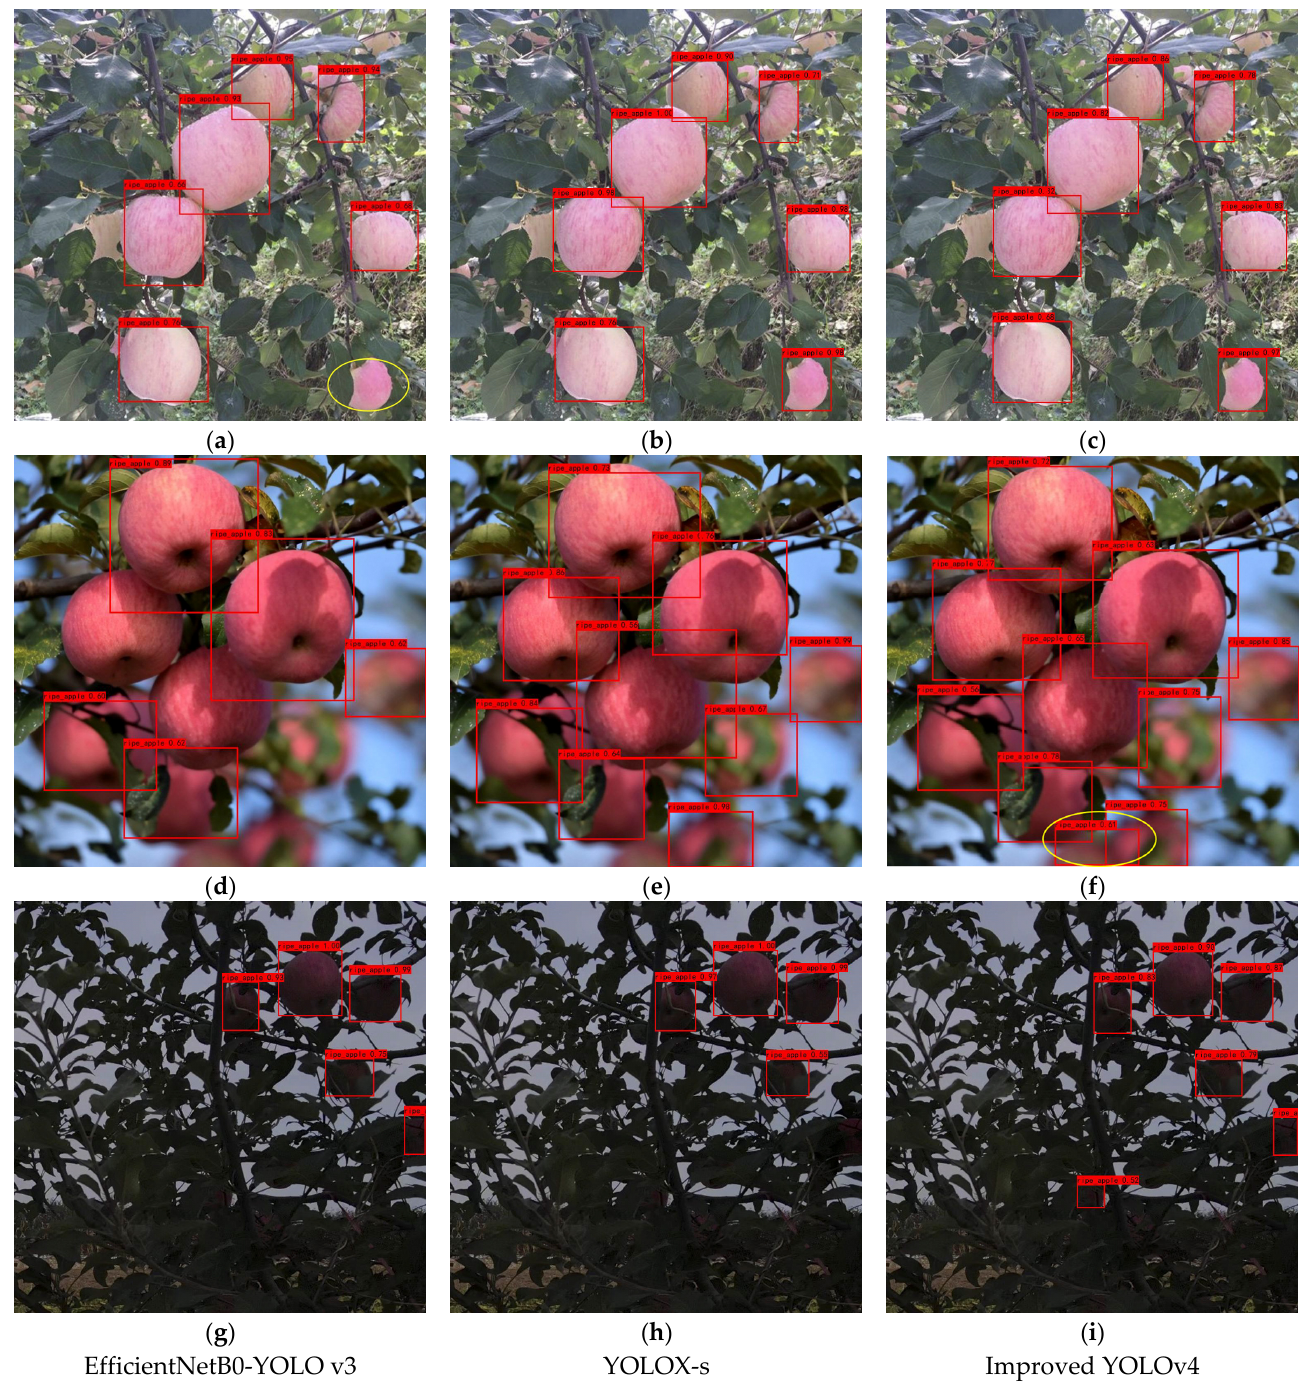
Figure 12. Comparison of recognition effects of three models under different illumination conditions: ( a – c ) the recognition effect in the front light condition; ( d – f ) the recognition effect in the side light condition; and ( g – i ) the recognition effect in the back light condition.